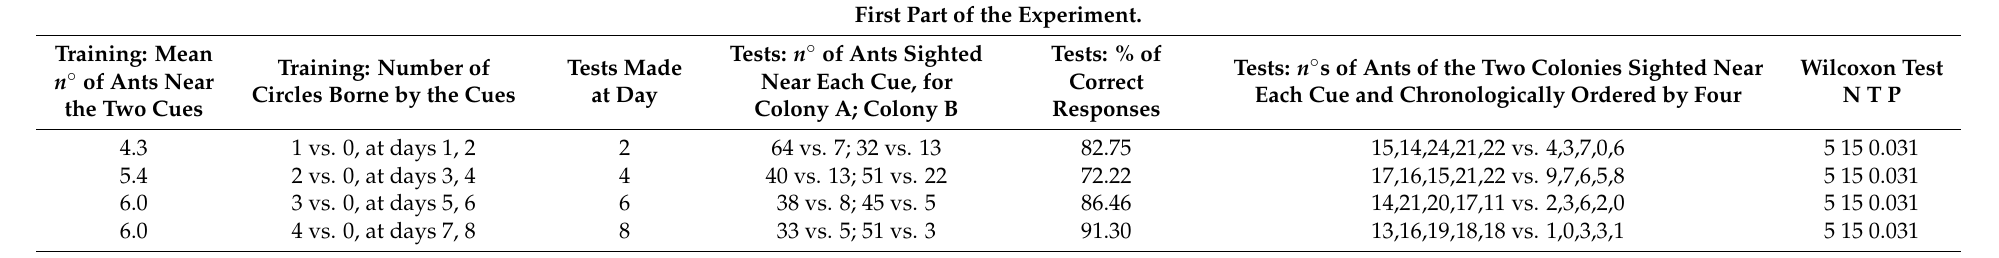
Table 1. Results of experiments made for examining if ants could anticipate the following term in an increasing sequence of numbers. First Part of the